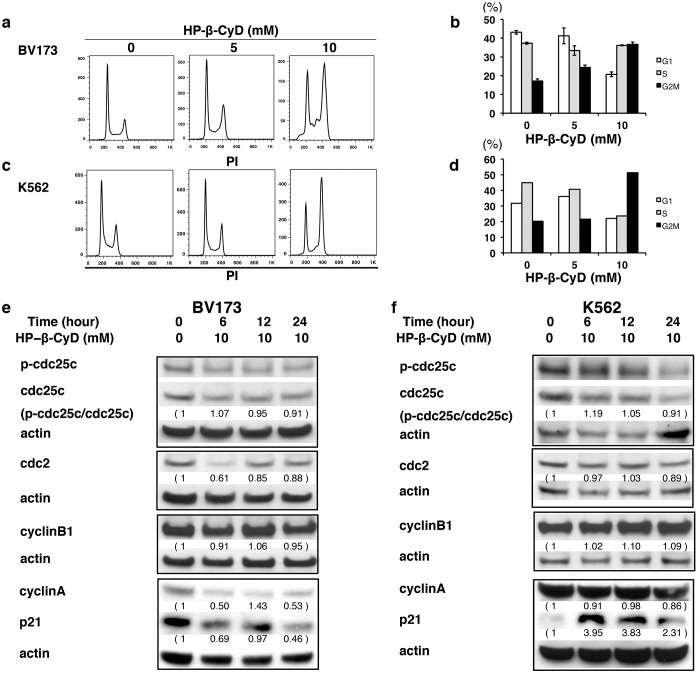
HP-β-CyD causes cell-cycle arrest in leukemic cells.(A–D) BV173 and K562 cells were treated with the indicated concentration of HP-β-CyD for 12 hours, then flow cytometric analysis of PI-stained nuclei was performed. (A) Representative flow cytometric histograms of PI-stained BV173 cells. (B) The percentage of cells in G0/G1, S, or G2/M phase was assessed in viable BV173 cells. White: G1-phase, gray: S-phase, black: G2/M-phase. (C) Representative flow cytometric histograms of PI-stained K562 cells. (D) The percentage of cells in G0/G1, S, or G2/M phase was assessed in viable K562 cells. White: G1-phase, gray: S-phase, black: G2/M-phase. (E and F) Effects of HP-β-CyD on the expression of G2/M cell-cycle-associated proteins. BV173 (E) and K562 cells (F) were treated with 10 mM HP-β-CyD for the indicated times. Cells were lysed and analyzed by Western blotting. Western blot images are representative results from at least two independent experiments. Detection of β-actin was used as a loading control. Intensity of the immunoblot signals after background subtraction was quantified using ImageJ software.